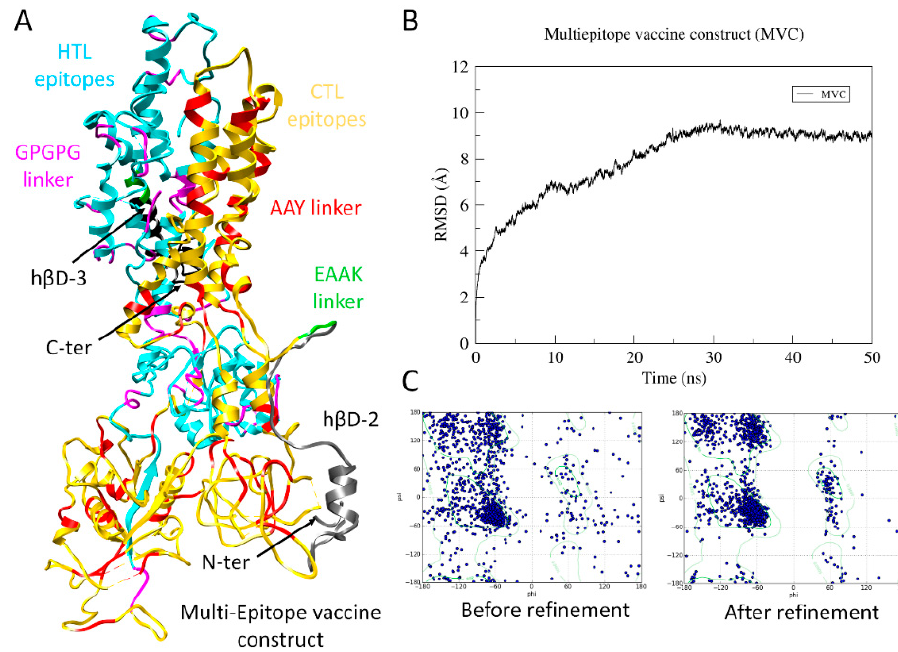
Figure 2. Molecular modeling of vaccine construct. ( A ) Structural representation of multiepitope vaccine construct (MVC) is displayed with regions (helper T lymphocytes (HTL), cytotoxic T-lymphocyte (CTL) epitopes, linkers, and adjuvants) highlighted accordingly. ( B ) Root mean square deviation trajectory (RMSD) of MVC analyzed over a period of 50 ns molecular dynamics (MD) simulations. ( C ) Ramachandhran evaluations of MVC before and after refinement through MD simulations.